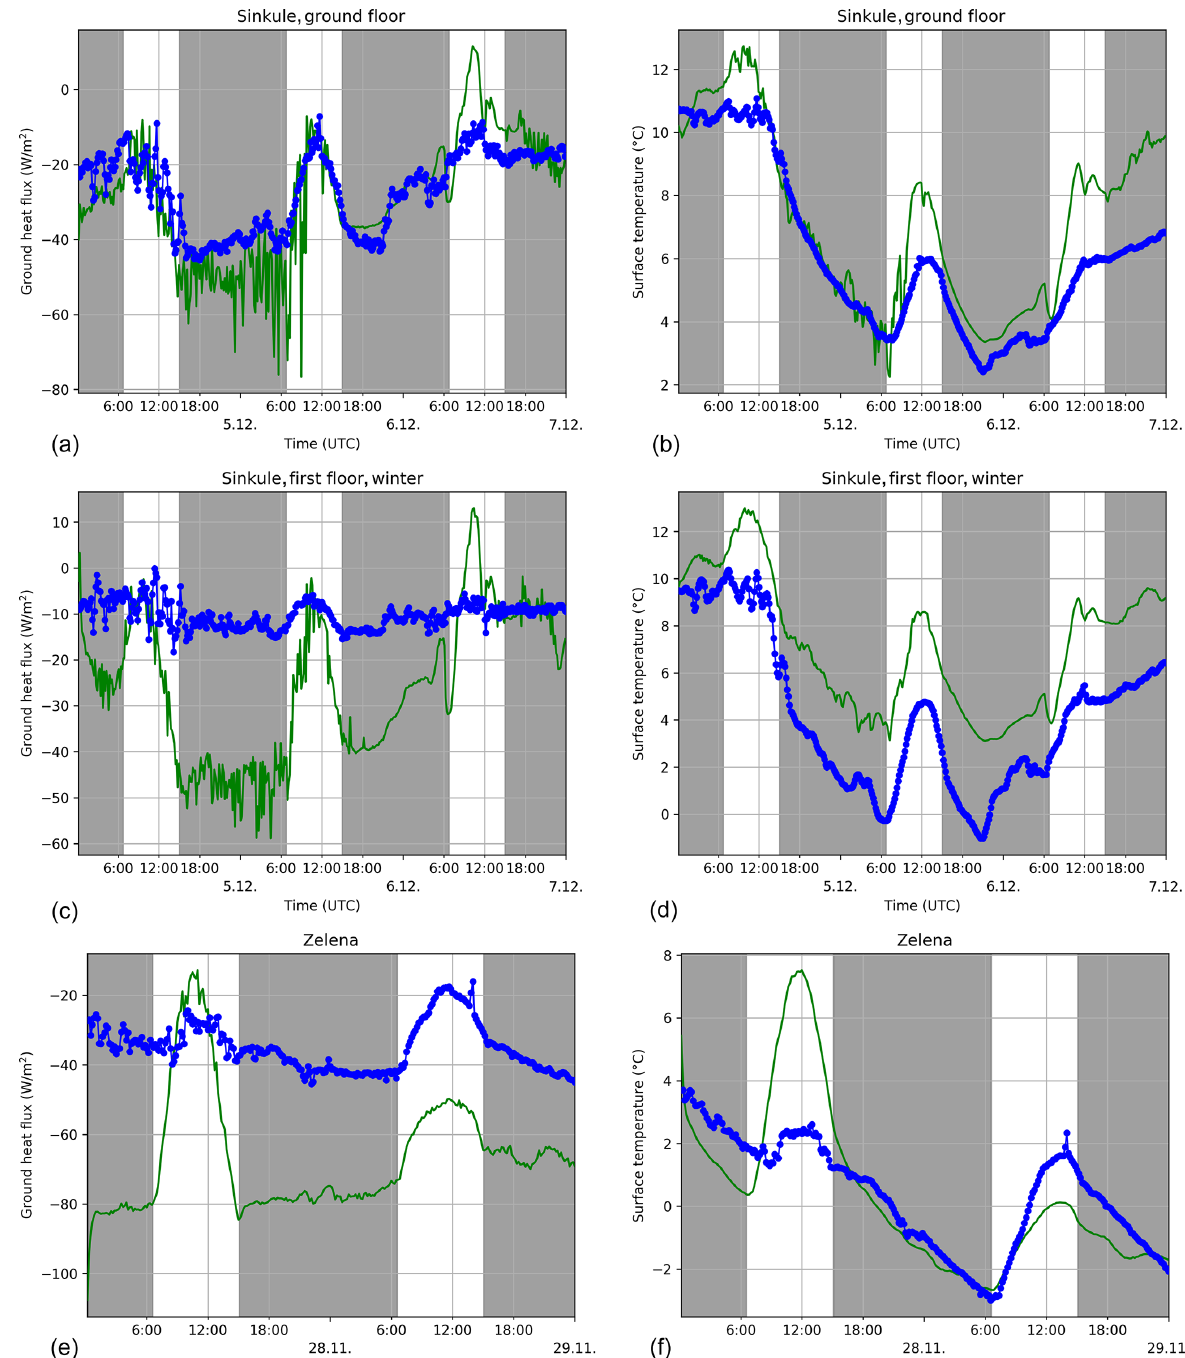
Figure 25. Modelled (green) and observed (blue) wall heat flux (a, c, e) and surface temperature (b, d, f) for 5–6 December for the ground floor (a, b) and the first floor (c, d) at the Sinkule house location, and at the Zelená location on 27–28 November (e, f) . The grey areas denote